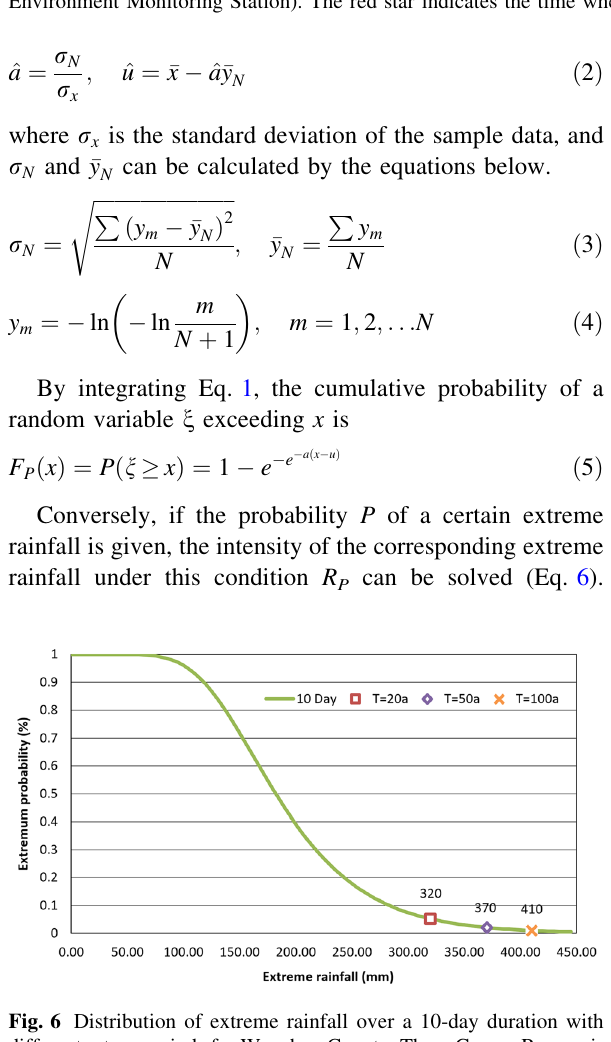
Fig. 5 Bi-monthly rainfall in Wanzhou County in 1964–2013, Three Gorges Reservoir region (data collected from the Wanzhou Geological Environment Monitoring Station). The red star indicates the time when landslide occurred